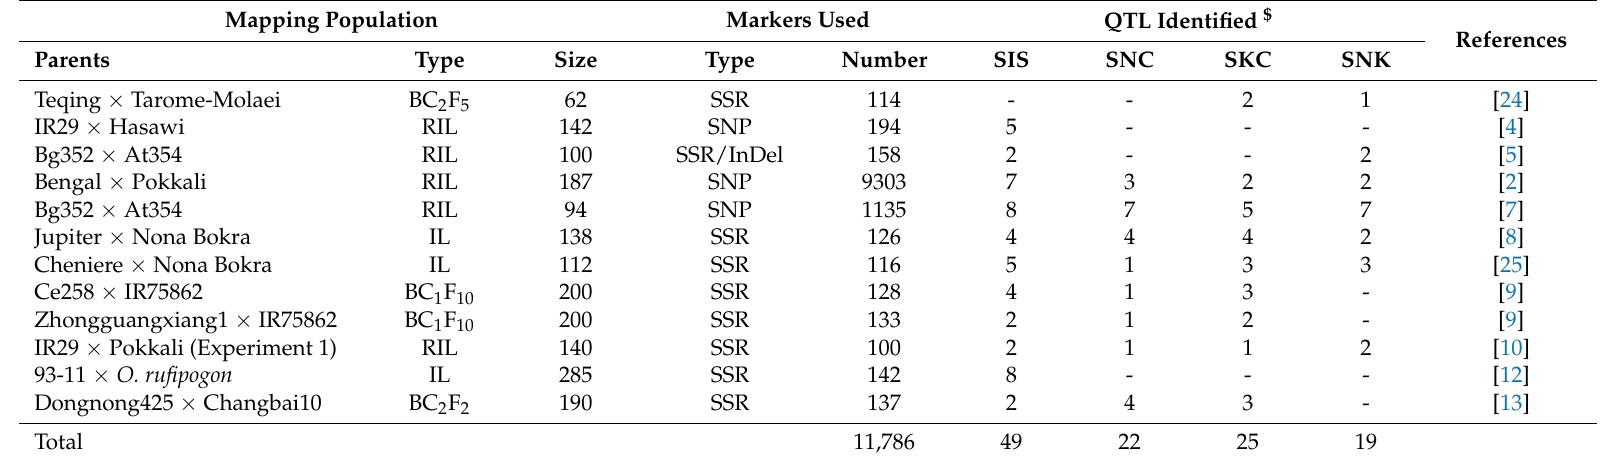
Table 1. The QTL mapping studies used for meta-QTL analysis for traits associated with seedling-stage salt tolerance. Mapping